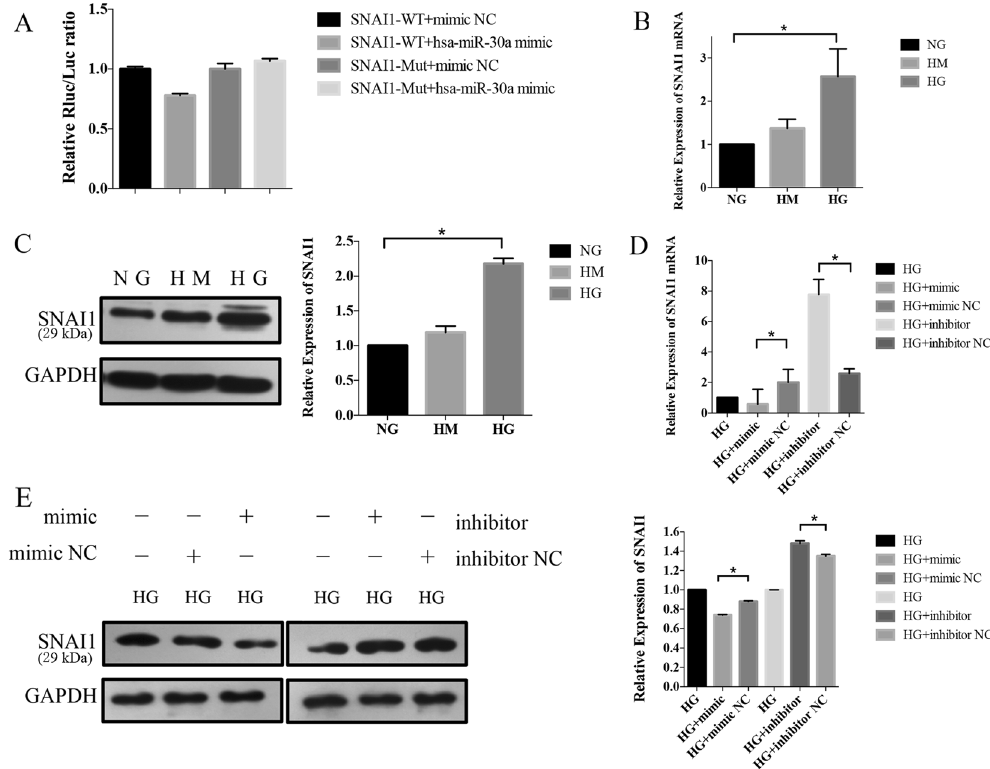
Figure 3. MiR-30a-5p directly targeted and regulated SNAI1 in the diabetic cataract model in vitro . ( A ) A dual luciferase reporter assay. When pmiR-RB-REPORT-SNAI1-3 ′ UTR and miR-30a-5p mimic were cotransfected, a significant decrease in relative luciferase activity was observed. The mutation of the perfectly complementary sites in the SNAI1-3 ′ UTR disrupted the interaction between miR-30a-5p and Snai11 and abolished the suppressive effect. ( B ) The mRNA expression of SNAIl. qRT-PCR showed the SNAI1 mRNA expression increased significantly in HG (NG as control, * P < 0.05, N = 1). ( C ) The protein expression of Snail in Western blot. Left: The representative gel results (top, data from the gels; bottom, normalization to GAPDH); Right: The normalized graphs results. The result showed an increased expression of SNAI1 in HG conditions (NG as control, * P < 0.05, N = 2). ( D ) Results of qRT-PCR in the transfected LECs. There were five groups in this part: 1, capsular bags cultured in HG for 3 days were used as the control group; 2, the cells were transfected with a mimic negative control (NC) of miR-30a-5p; 3, the cells were transfected with a mimic of miR-30a-5p; 4, the cells were transfected with an inhibitor of miR-30a-5p; and 5, the cells were transfected with an inhibitor NC of miR-30a-5p. SNAI1 mRNA levels were significantly increased by the miR-30a-5p mimic ( * P < 0.05, mimic NC as control, N = 1) and decreased by the miR-30a-5p inhibitor ( * P < 0.05, inhibitor NC as control, N = 1). ( E ) Results of Western blotting in the transfected LECs (top, data from the gels; bottom, normalization to GAPDH). SNAI1 protein expression was decreased by transfection with the miR-30a-5p mimic ( * P < 0.05, mimic NC as control, N = 2) but restored by transfection with the miR-30a-5p inhibitor ( * P < 0.05, inhibitor NC as control, N = 2) in the LECs